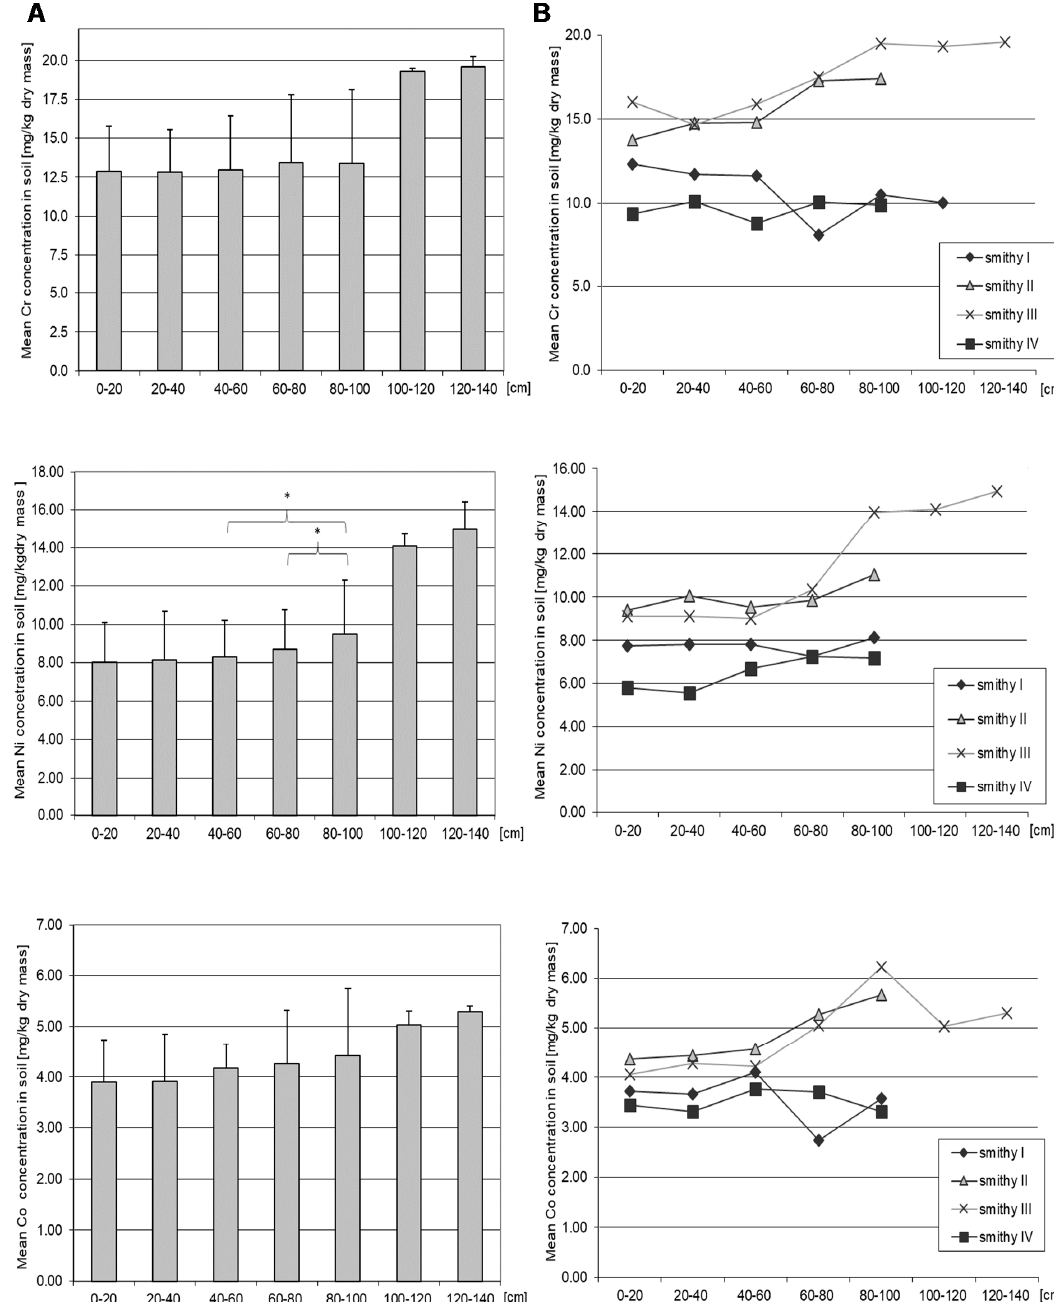
Figure 4. Mean concentration of Cr, Ni, Co in soil depending on the depth of sampling ( A ) and depending on the site and the depth of sampling ( B ). Data represent the means ± SD for 3 independent measurements. There is no statistically significant differences in Cr and Co concentration depending on the depth of sampling (Mann-Whitney U test). * p < 0.05, statistically significant differences in Ni concentration depending on the depth of sampling (Mann-Whitney U test). Statistically significant differences depending on the site of sampling (Wilcoxon test), see Supplementary Table S2.